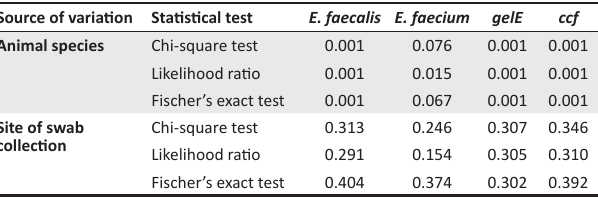
TABLE 4: Null model output from binary logistic regression showing association of virulence genes detected in Enterococcus spp. between companion animals and livestock.